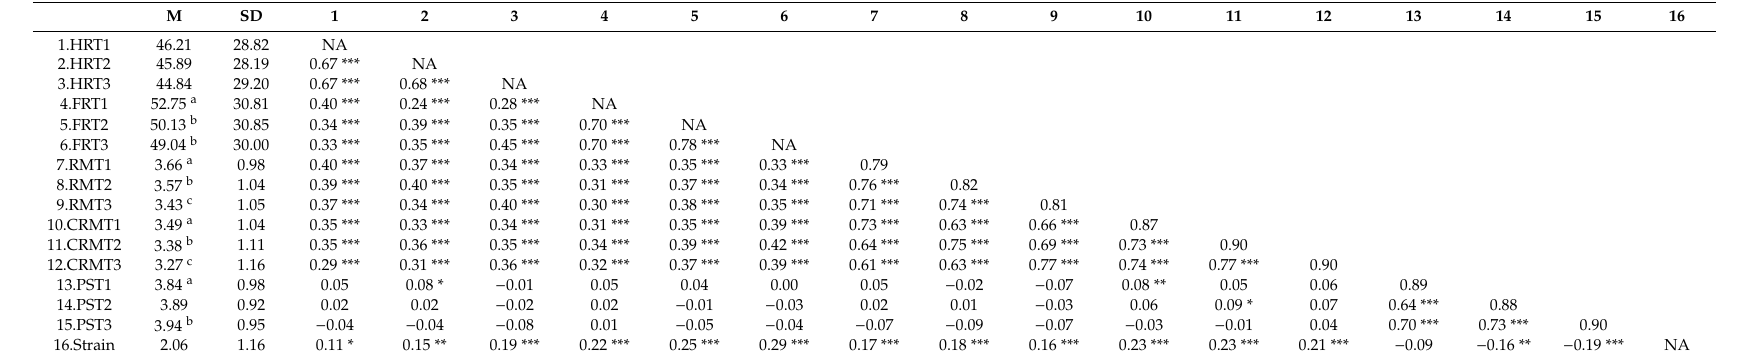
Table 4. Means, Standard Deviations, and Bivariate Correlations of Psychosocial